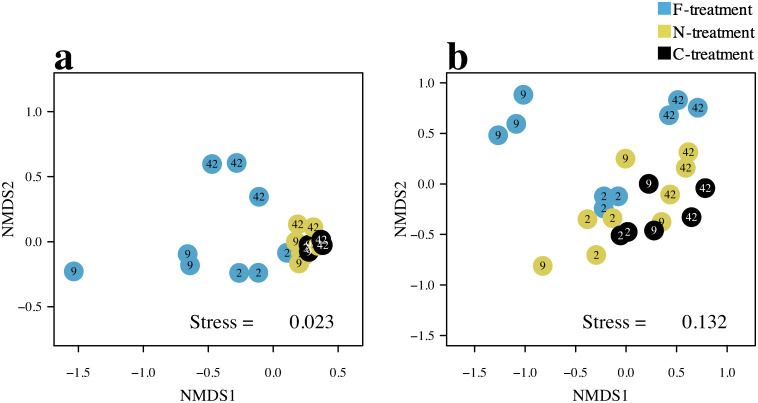
Temporal changes in the similarity among microbial assemblages.The similarities of (a) bacterial and (b) ciliophoran assemblages are shown as non-metric multidimensional scaling plots using the Horn index. Dates examined are denoted by figures in circles.